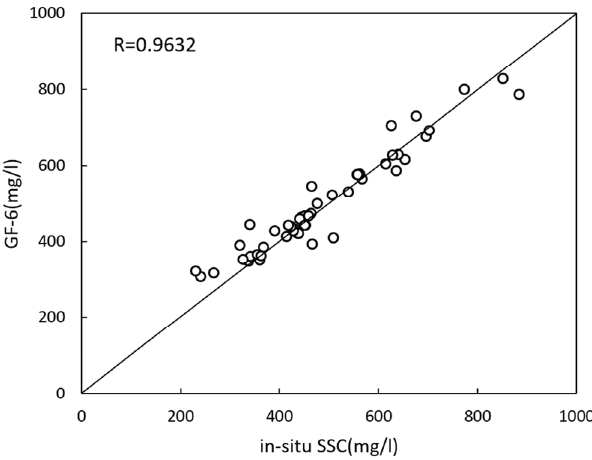
Figure 2. Verification of the inversion model with in situ